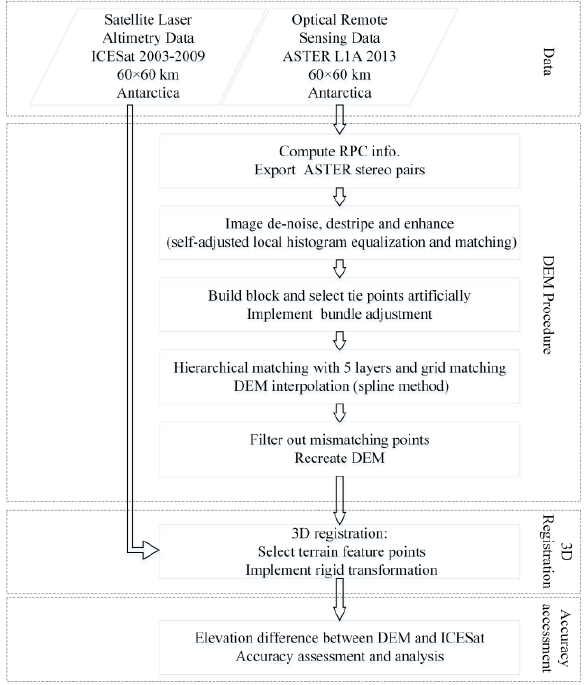
Figure 2. Flowchart of DEM Extraction and 3D Registration.